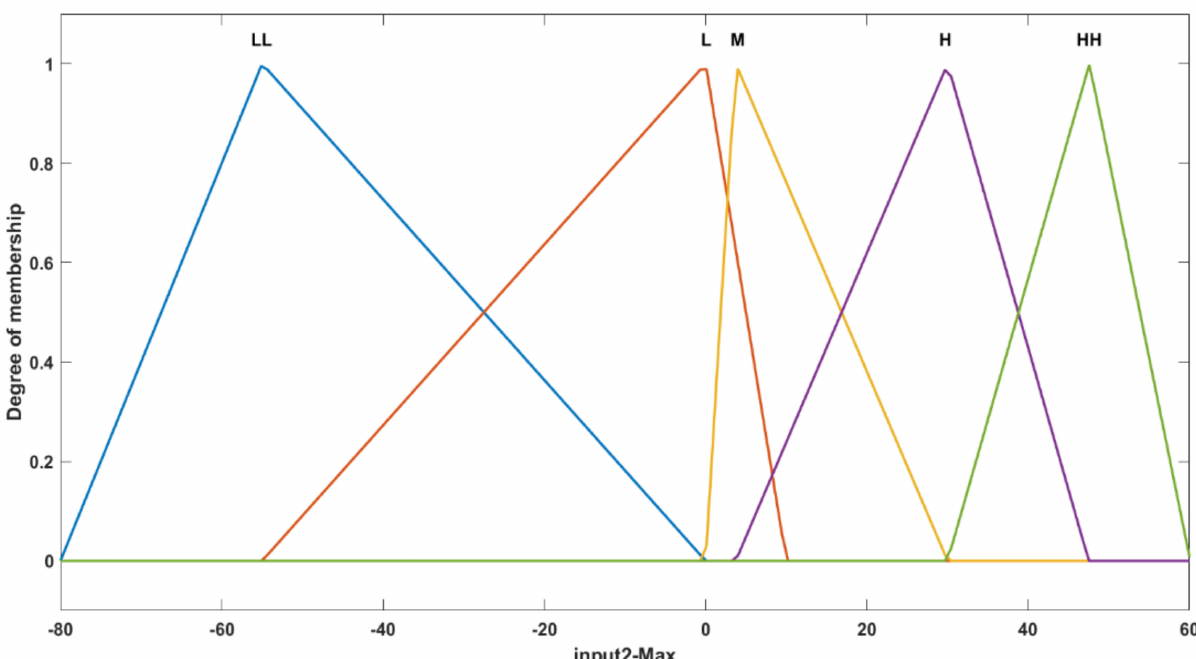
Figure 7. The membership function for input-2 to the fuzzy classifier based on the max values of frequency responses.